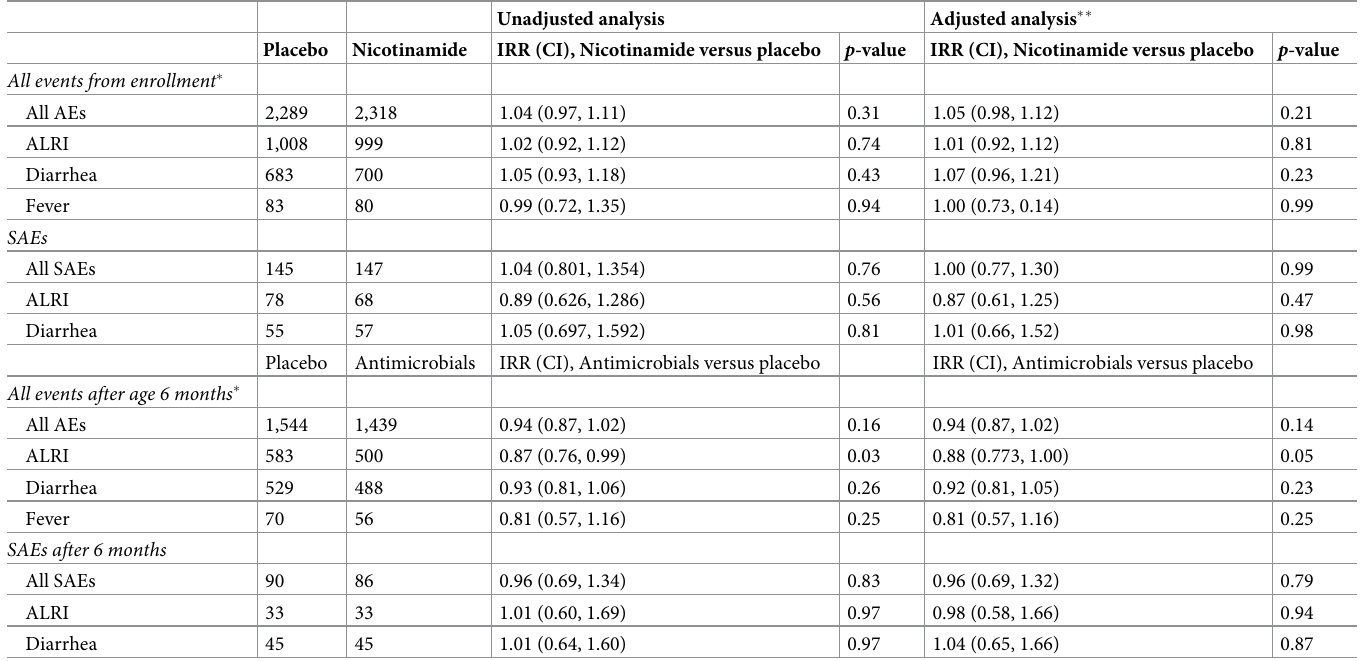
Table 3. AEs and SAEs by intervention group (beginning at time of first nicotinamide dose at enrollment and first antimicrobial dose at 6